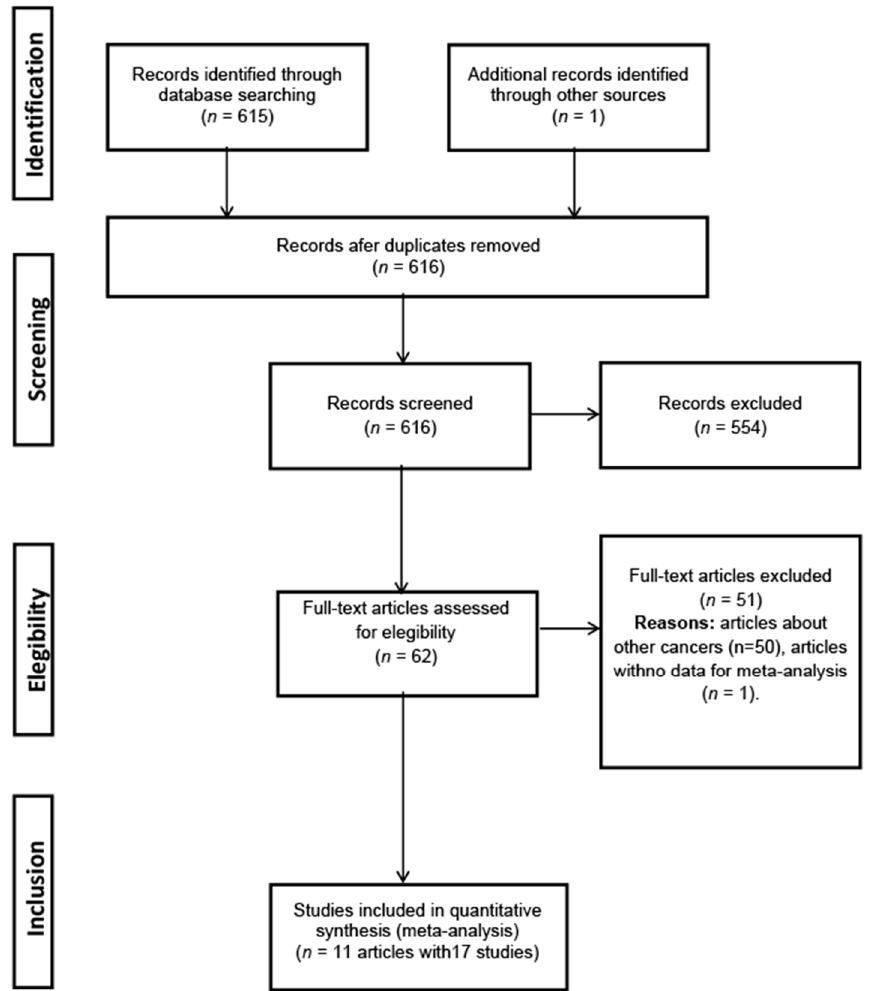
Figure 1. Flow chart of study selection.